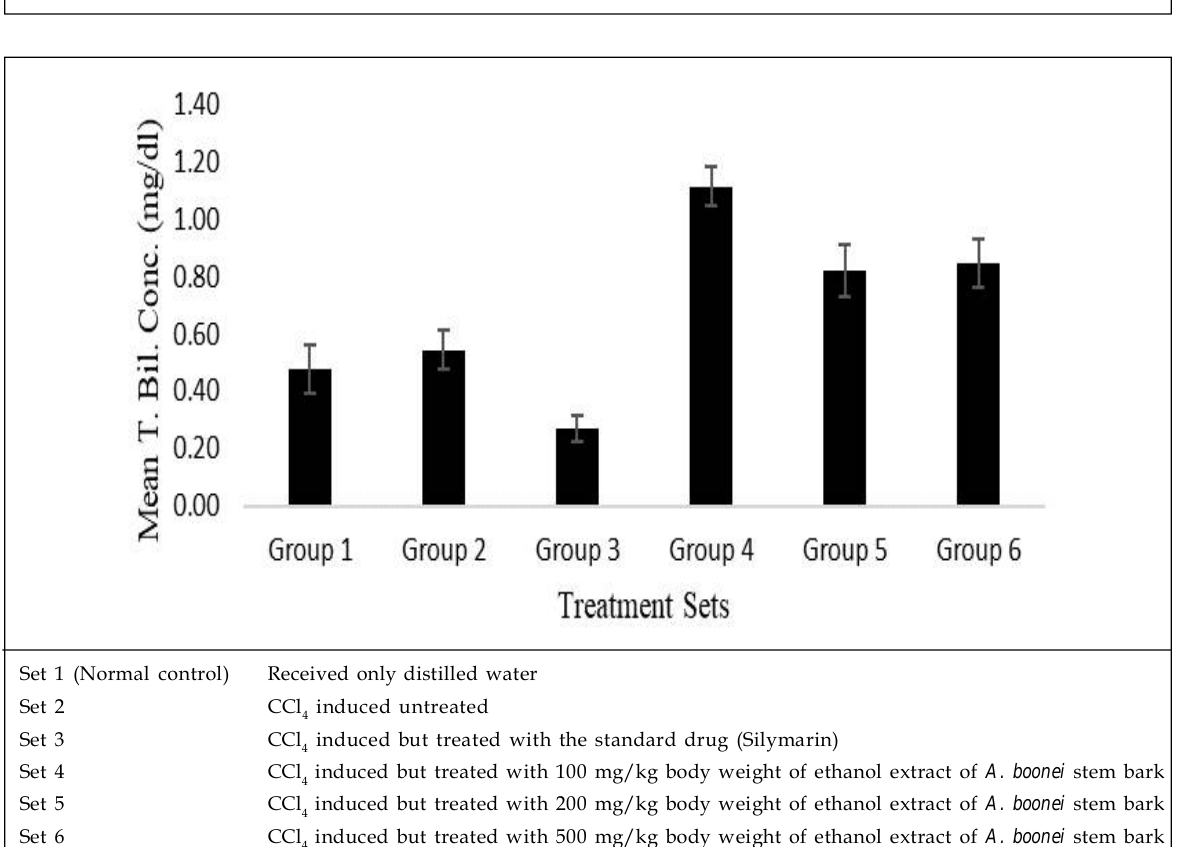
Figure 3: Total protein (TP) concentration of carbon tetrachloride (CCl administered ethanol extract of A. boonei stem bark